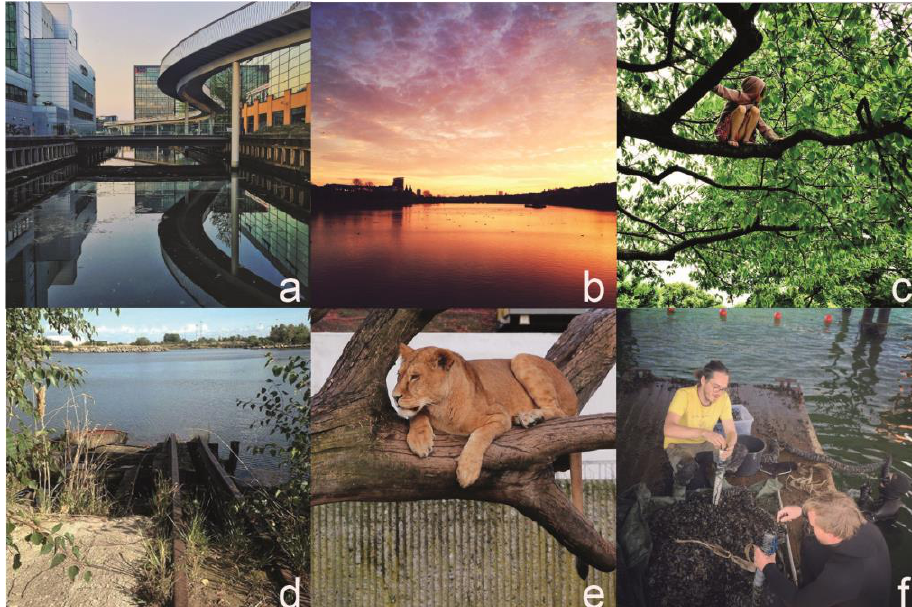
Figure 4. Examples of urban nature images as categorised. Photographer’s Instagram user names in parenthesis (start- ing from top left): a: Designed (@tbsptrsn), b: The Elements (@might_be_wrong), c: Biocultural (@remosteen) d: Spon- taneous (@copenhagen_streetlife), e: Domesticated—showing a lion from the Copenhagen zoo (@mmhenriksen), and f: Productive—showing oyster harvest in Copenhagen harbour (@maritimenyttehaver).